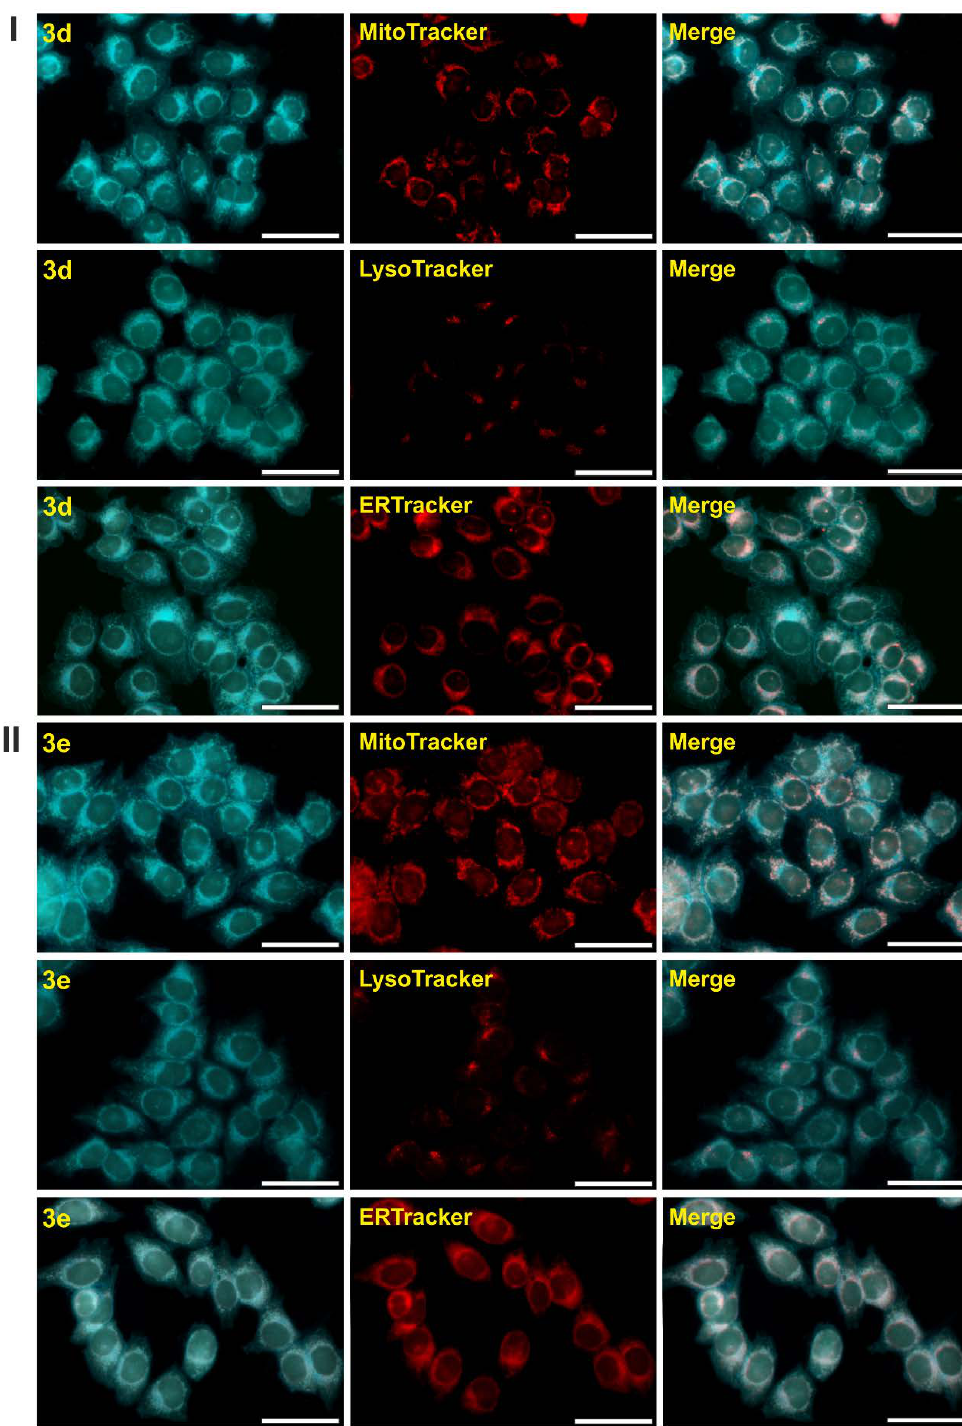
Figure 10. Fluorescence images of the HCT 116 cells that were incubated with 3d ( I ) and 3e ( II ) (both at a concentration of 25 µ M), for 1 h at 37 ◦ C. The images show a co-localization with specific-organelle trackers—the mitochondria, lysosomes, and endoplasmic reticulum. The first panel represents the fluorescence of the 3d and 3e compounds alone, the middle panel—the specific dyes, and the last—the merged. Scale bars indicate 50 µm. The absorption profile of the tested compounds enabled their excitation with a DAPI wavelength and the large Stokes shift helped to minimize the self-quenching e ff ect and also boosted the signal-to-noise ratio, which in turn enabled us to obtain images of a good